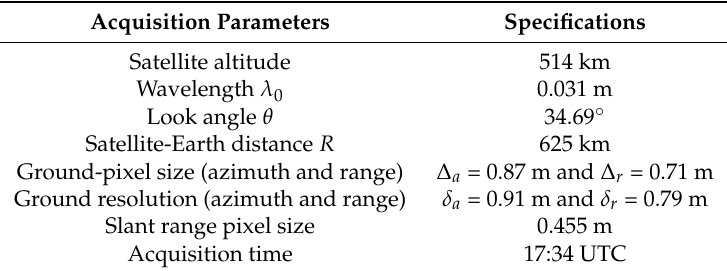
Table 1. Acquisition parameters of the TerraSAR-X temporal